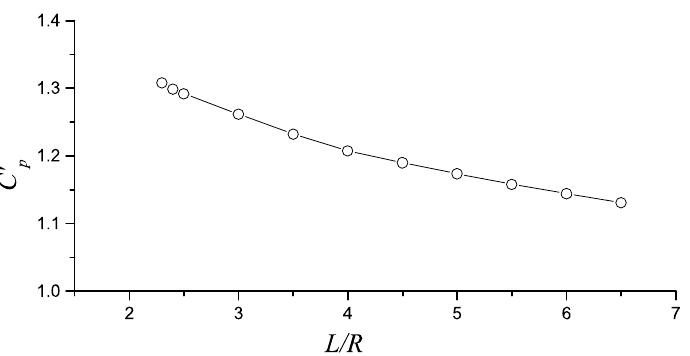
Figure 9. The relative power coefficient varies with the spacing in parallel connection where λ = 2.5.